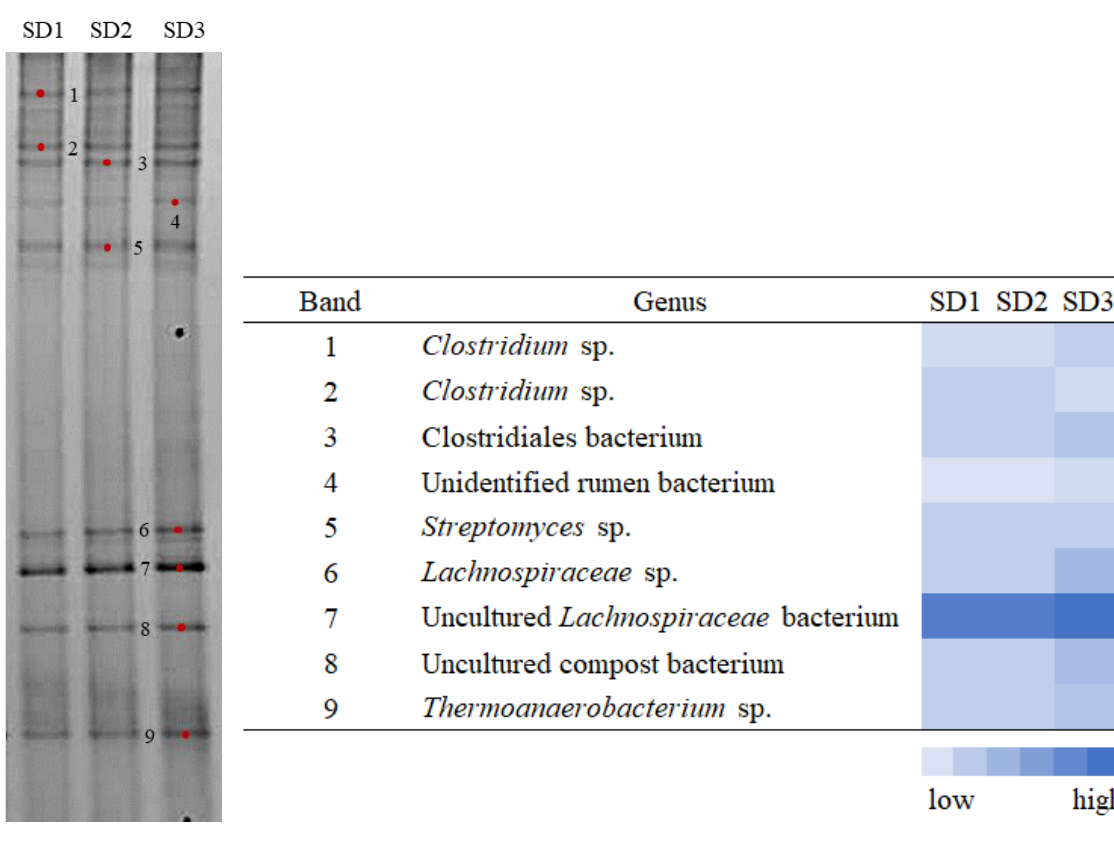
Figure 4. Bacteria DGGE profile of ( a ) elephant dung enrichment in each repetitive sub-culture for five generations and ( b ) sludge from hydrogen reactor of sawdust at different loading.